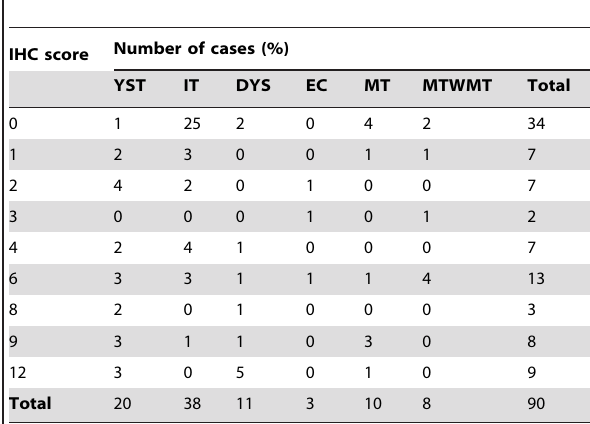
Table 2. Immunohistochemistry score distribution of all cases